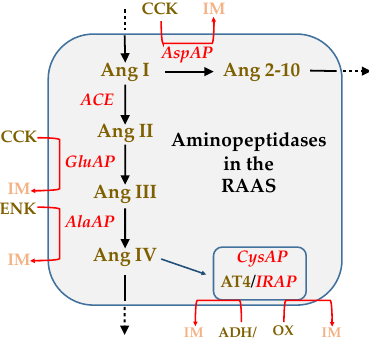
Figure 1. Schematic representation of a part of the renin-angiotensin-aldosterone system (RAAS) in which the aminopeptidase activities determined in the present work are involved. Angiotensin I (Ang I), produced by the action of renin on angiotensinogen, is hydrolyzed by aspartate aminopeptidase (AspAP) to produce Ang 2–10. AspAP can also metabolize cholecystokinin (CCK) to an inactive metabolite (IM). Moreover, Ang I, due to the action of the angiotensin-converting enzyme (ACE), produces Ang II, which is hydrolyzed to Ang III through the action of glutamate aminopeptidase (GluAP), which can also act on CCK to produce an IM. Ang III, through alanine aminopeptidase (AlaAP), will give rise to Ang IV but can also inactivate enkephalin (ENK). Ang IV binds to the AT 4 receptor that has been identified as the insulin-regulated aminopeptidase (IRAP), also known as CysAP, oxytocinase (which inactivates oxytocin, OX), or vasopressinase (which inactivates vasopressin, VP or antidiuretic hormone, ADH)